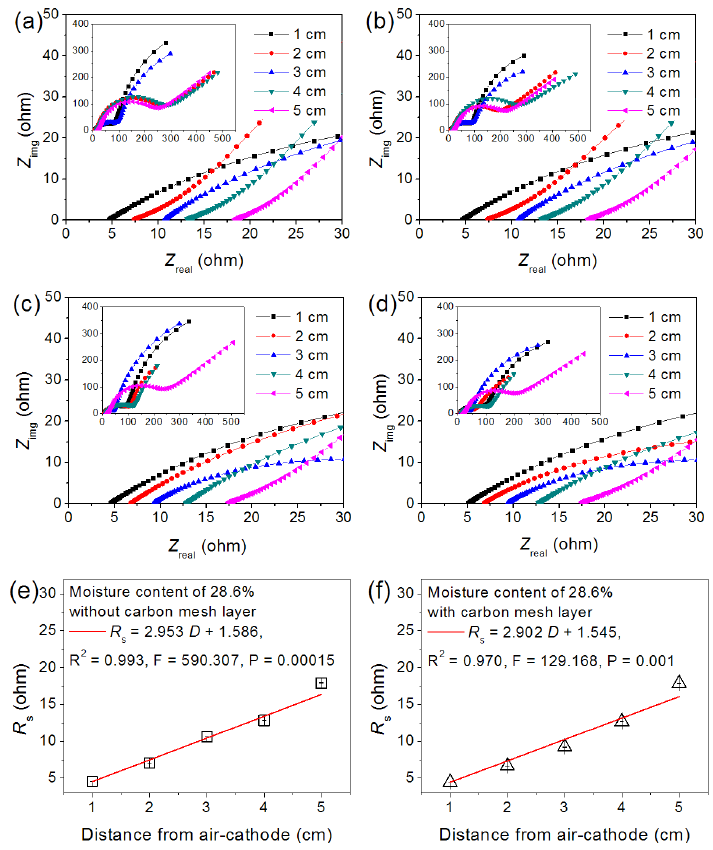
Figure 4. Nyquist plots measured with multiple ( a , b ; duplicated values) and single ( c , d ; duplicated values) layer of carbon mesh. Linear fittings of multiple ( e ) and single layer ( f ) of carbon mesh between mean values of R s and electrode distance (28.6% of soil moisture content). Table 4. Conductivity and resistivity calculated from the linear fitting slope of R s and distance from air-cathode in Figure 5.